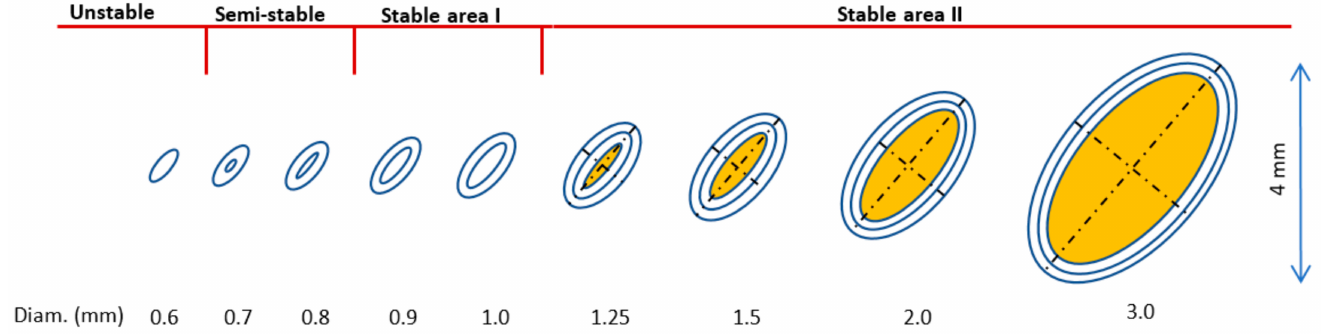
Figure 10. The schematic visualization of the used default SLM